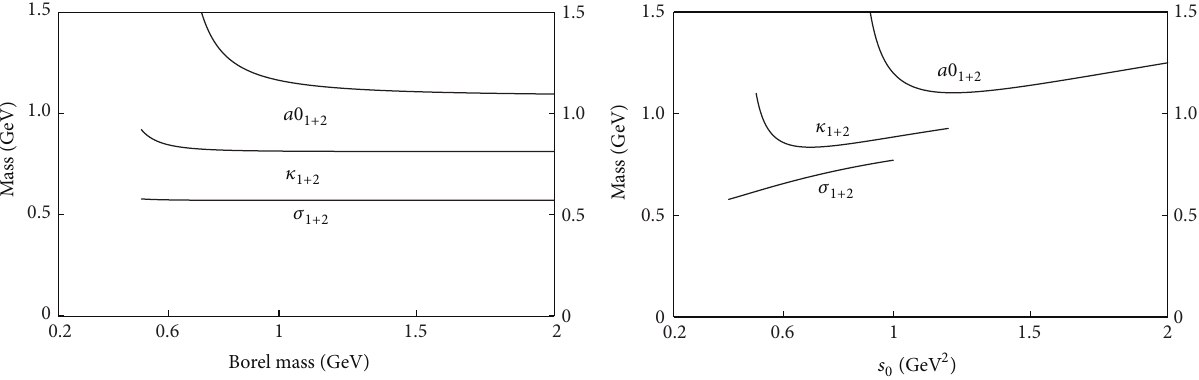
Figure 7: Masses of light scalar mesons 𝑓 0 (500) , 𝜅(800) , and 𝑎 0 (800) ( 𝑓 0 (980) ) as functions of the Borel mass 𝑀 𝐵 and the threshold value 𝑠 0 , where only the connected parts, (44), are taken into account. The threshold value 𝑠 0 for the left figure is chosen to be 0.4 GeV 2 , 0.8 GeV 2 , and 1.3 GeV 2 , while the Borel mass for the right figure is chosen to be 0.5GeV, 0.6GeV, and 1.5GeV, for 𝑓